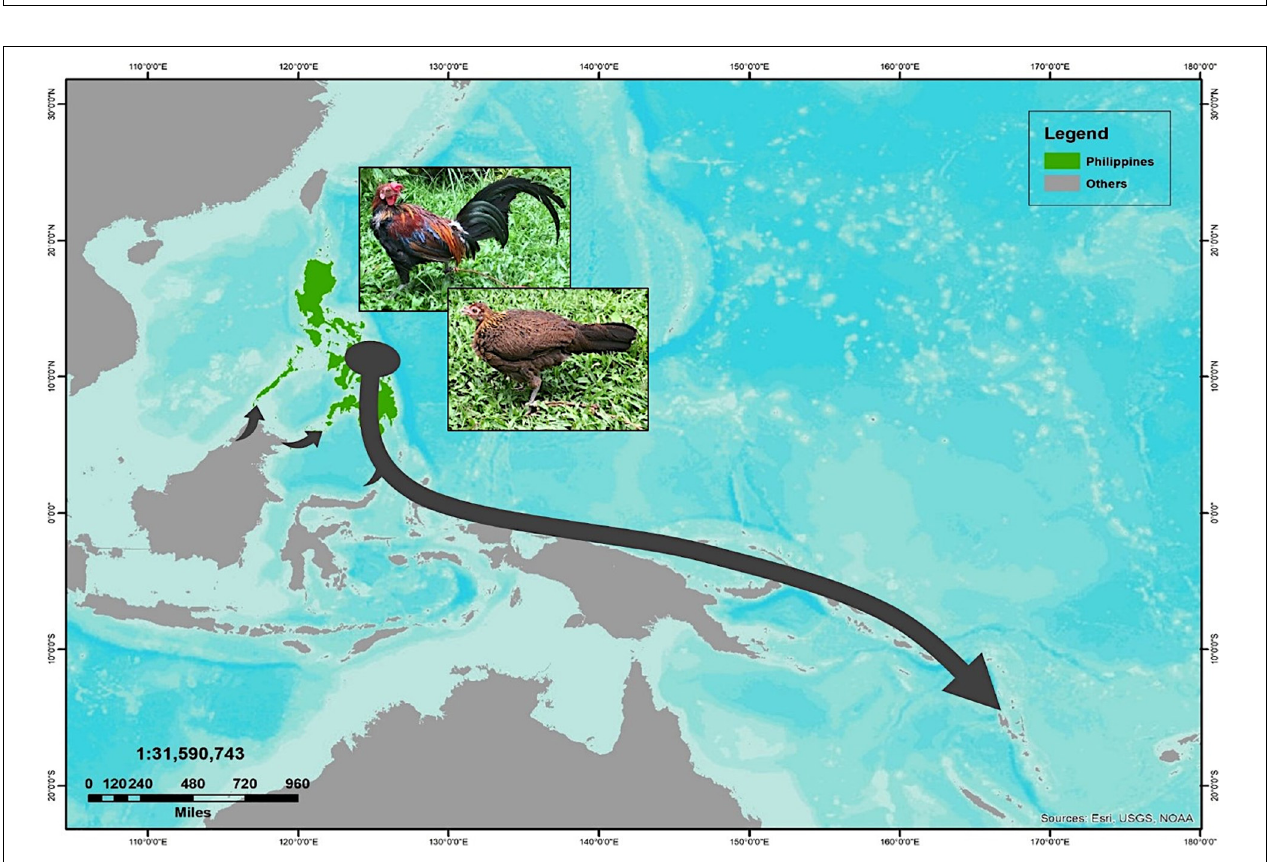
FIGURE 4 | Bayesian coalescent skyline plot showing estimated demographic history of Philippine chickens (haplogroup D). The central blue line is the median estimate effective population size. The shaded area shows the upper and lower estimates of 95% credibility interval. The vertical dotted line represents the median estimate of time to the most recent common ancestor. The x -axis is the time (in years before present), and the y -axis indicates population size (as the product of N e and the generation length in years).